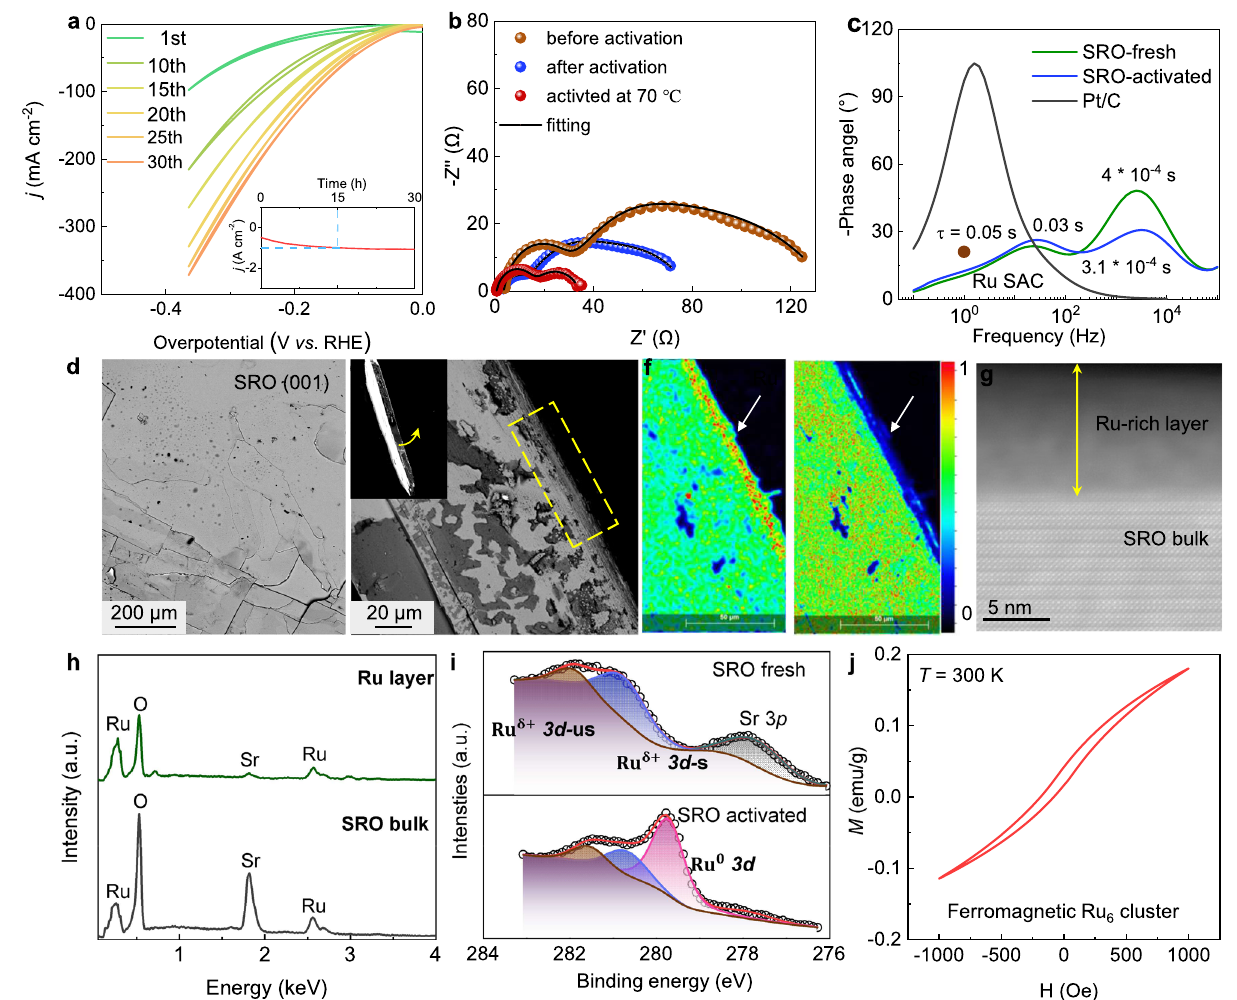
Fig. 3 | Structure of the SRO crystals after surface reconstruction. a Recorded CVcurvesinthe fi rst30cycleswiththefreshSRO crystal. b Nyquistplotsand c the corresponding Bode plots of SRO catalyst before and after HER testing. The used equivalent circuit to model the FRA spectra can be found in the supporting infor- mation.RuSACrepresentsRusingle-atomcatalyst. d SEMimageoftheSROcrystal surface after activation. e SEM image of the side view. The area marked with a yellow rectangle indicates the SRO surface that comes in contact with the